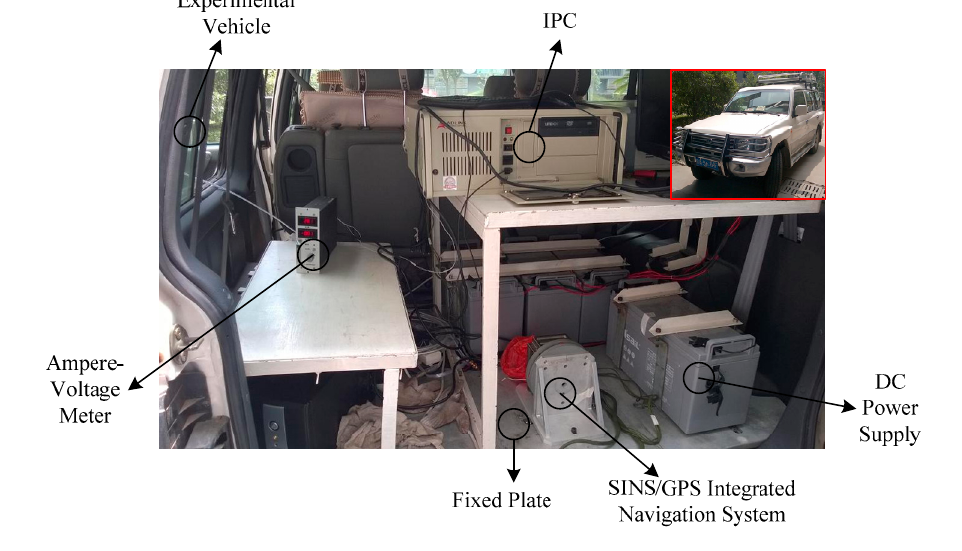
Figure 1. Experimental setup. Table 1. Specifications of the auxiliary facilities.